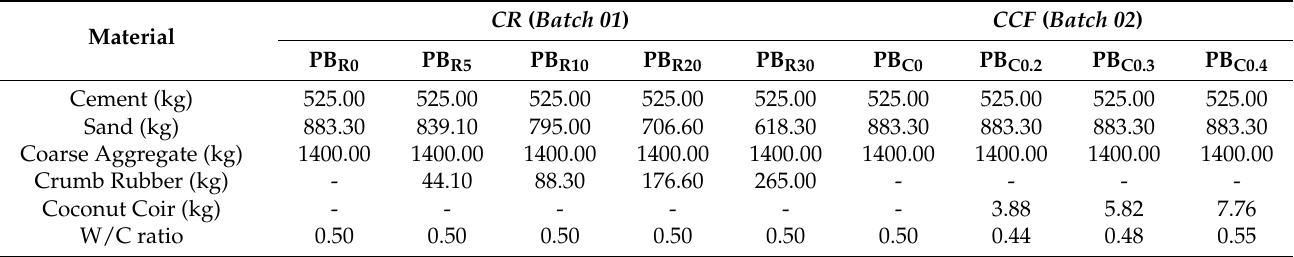
Table 2. Standards specified in code of practice for IPBs.